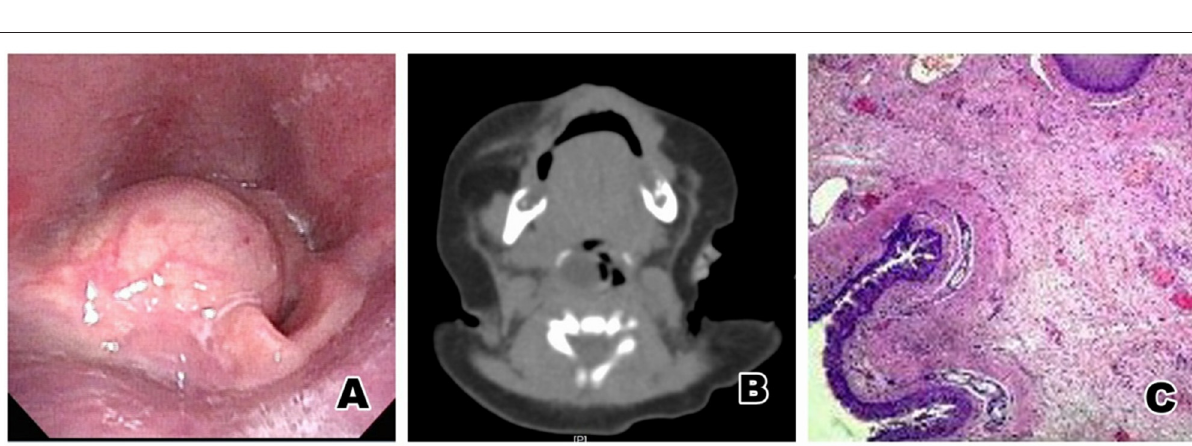
FIGURE 2 | (A) Electronic nasopharyngoscopy before surgery: New grayish white cystic objects are found in the right epiglottis and some aryepiglottic folds, ∼ 1.0 × 1.2cm in size, with a smooth surface and a obscured glottis. (B) Pharynx CT: A low density cystic shadow can be seen on the right laryngopharynx. (C) Pathological results: The cyst cavity was lined with ciliated columnar epithelium, smooth muscle tissue, fibers and cartilage, with chronic inflammatory cell and lymphocyte infiltration. The pathological result was a bronchogenic cyst of the